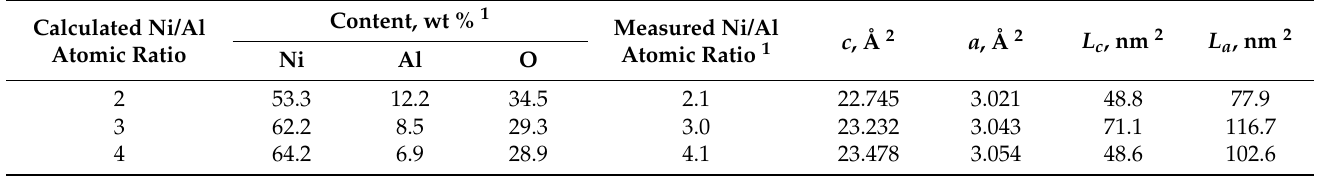
Table 1. Composition and structural characteristics of NiAl-CO 3